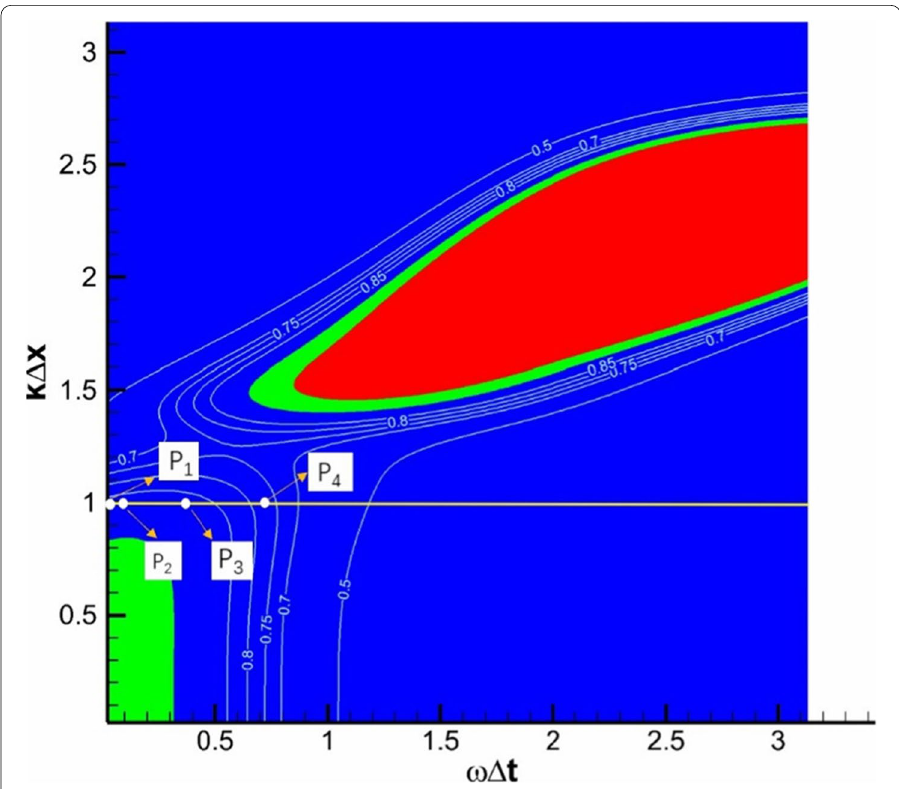
Fig. 5 Positions of P i in the k Δ x vs. ω Δ t plane. The colors indicate the group velocity calculated by QL-GRP with WENO5-JS and RK 4